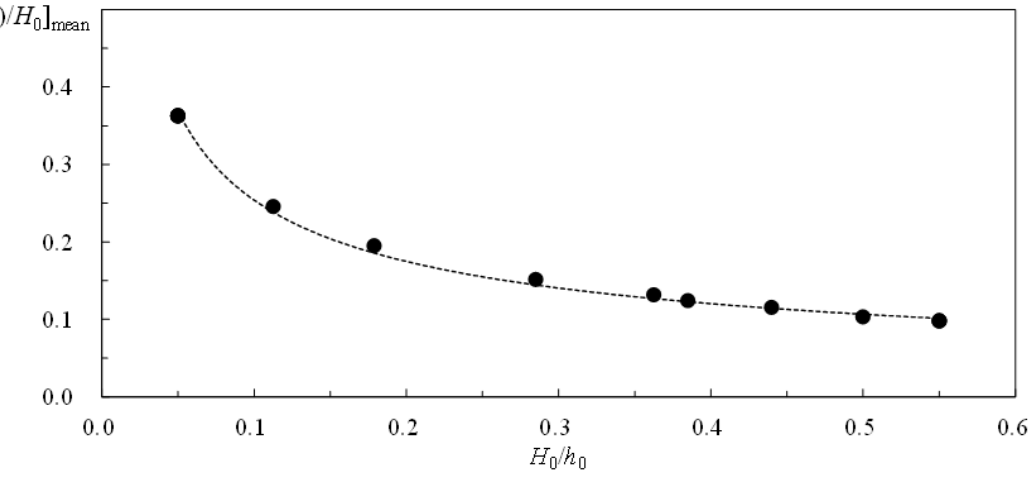
Figure 11. The relationship of [ η ( T )/ H 0 ] mean versus H 0 / h 0 for − 14.0 ≤ T ≤ 14.0.